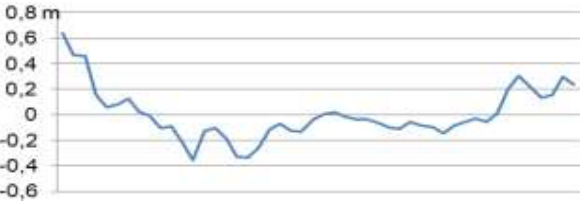
Figure 16. Averaged Cartosat-1 y-parallax over 34 km east-west